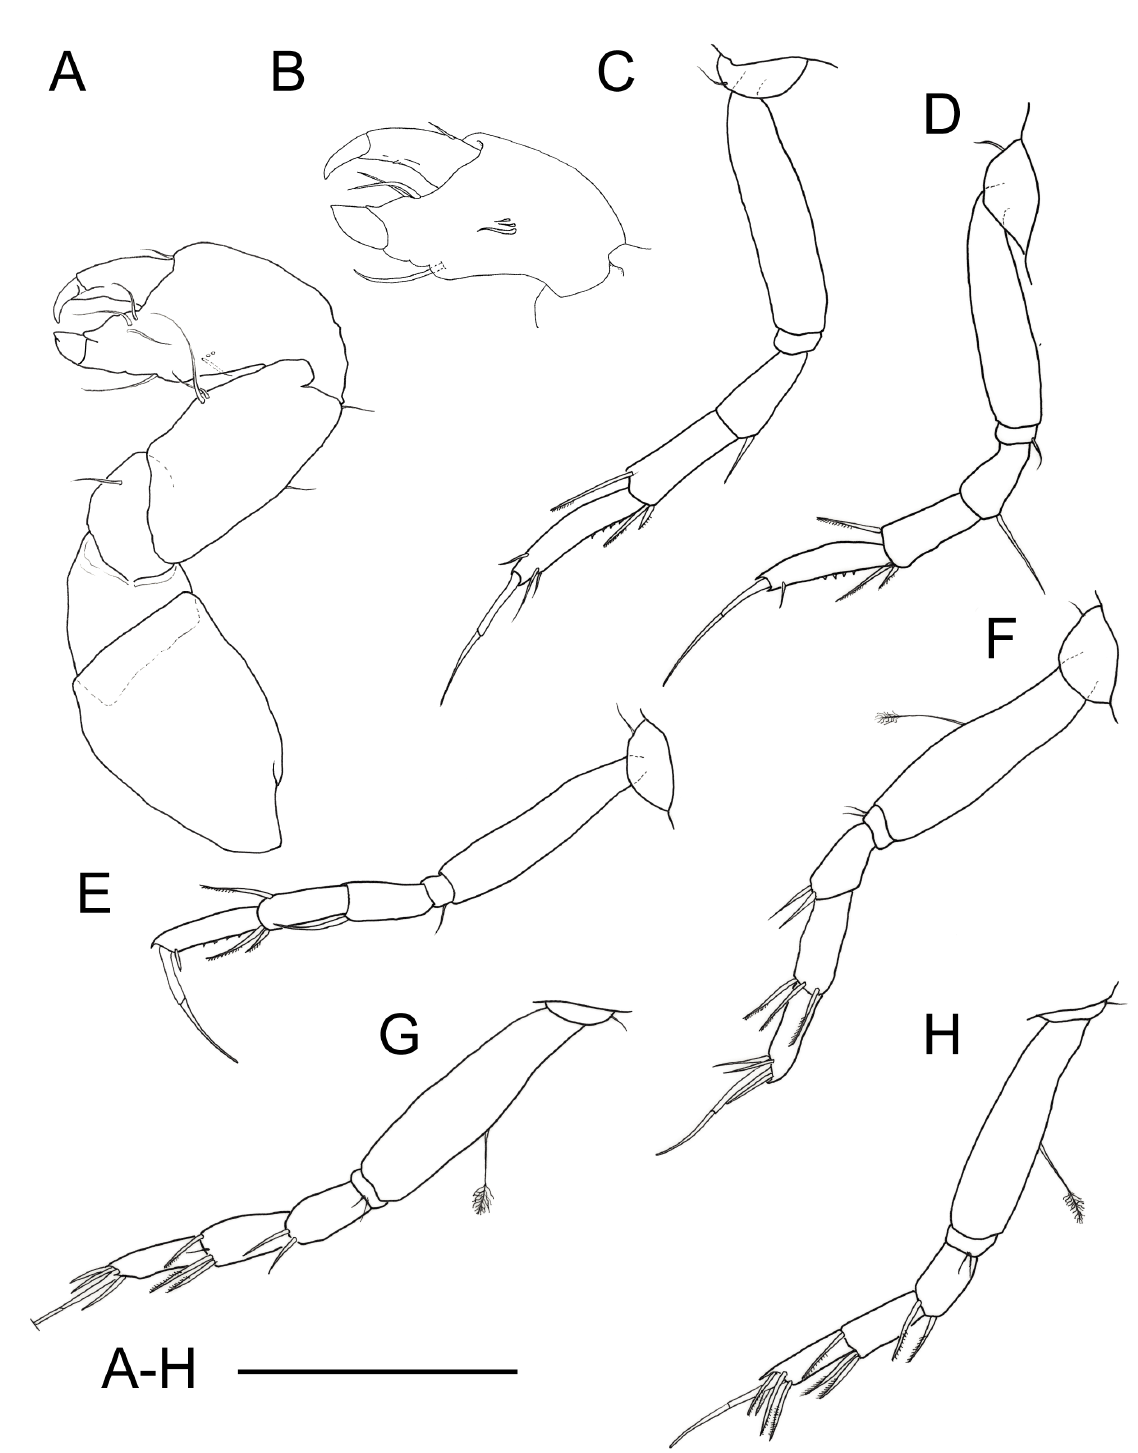
Fig. 5. Paranarthrura cousteaui sp. nov. Dissected paratype, adult, ♀ (DBUA0002189.03). A . Left cheliped outer view. B . Right cheliped inner view. C–E . Left pereopods 1–3. F . Right pereopod 4. G–H . Left pereopods 5–6. Scale bar = 100